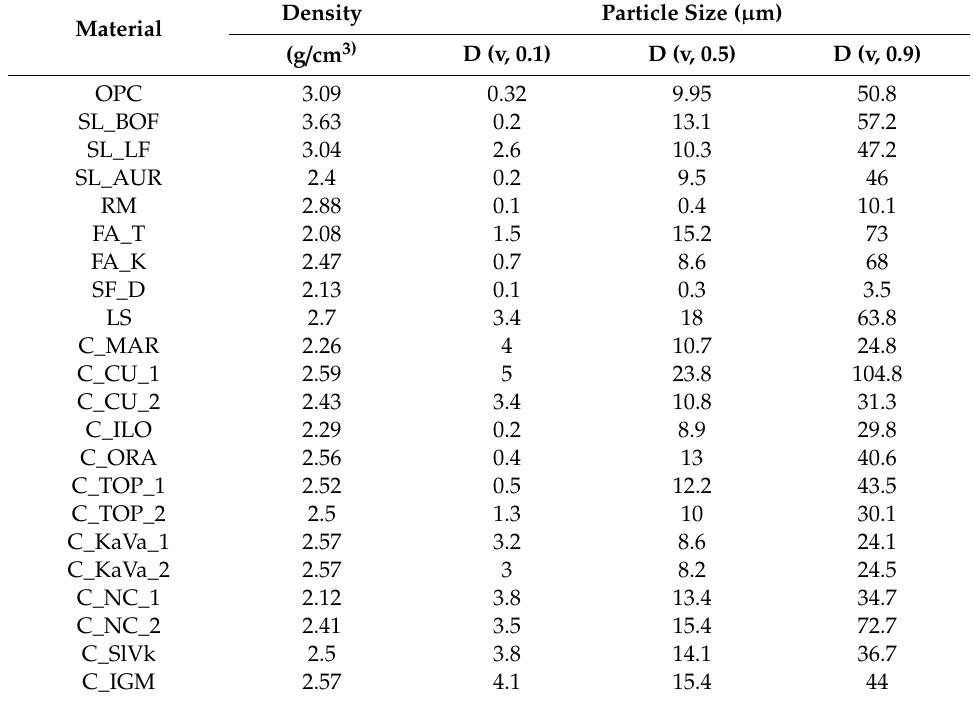
Table 2. Density and characteristic particle sizes of collected raw